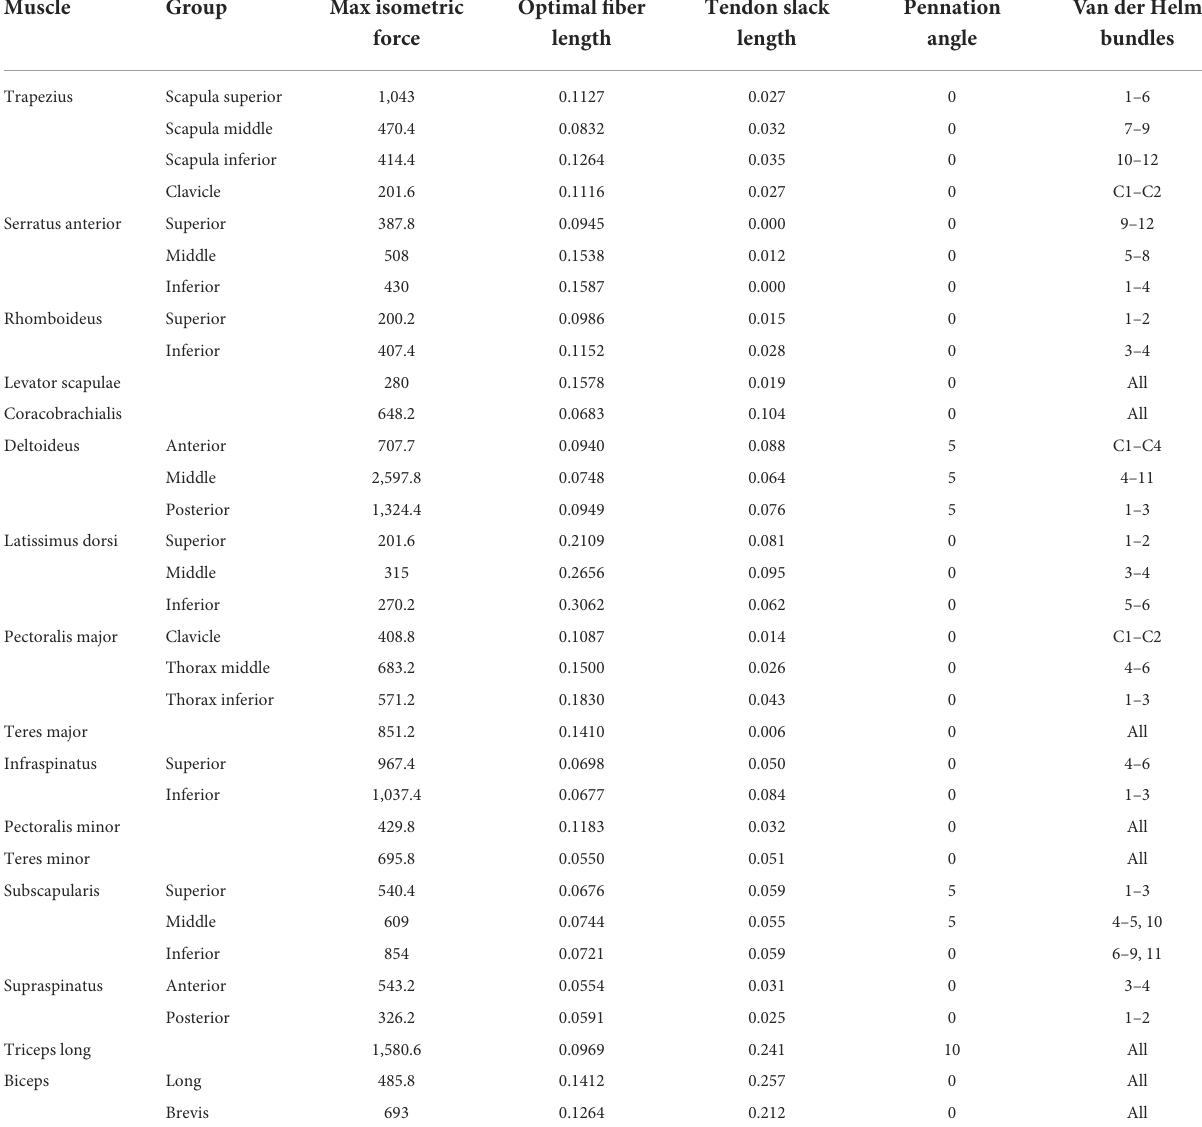
TABLE 2 Thoracoscapular shoulder model muscle parameters adapted from Breteler et al. (18) with aggregated bundles from by Van der Helm (19). Muscle